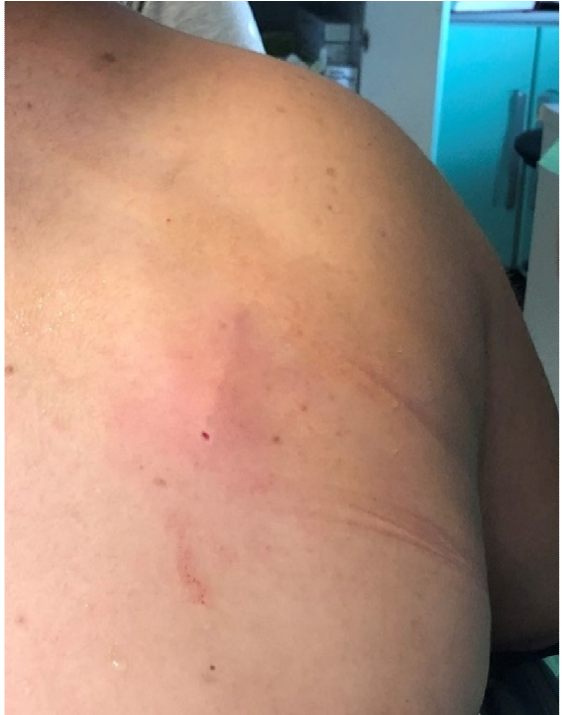
Figure 1. Nexplanon’s insertion site.